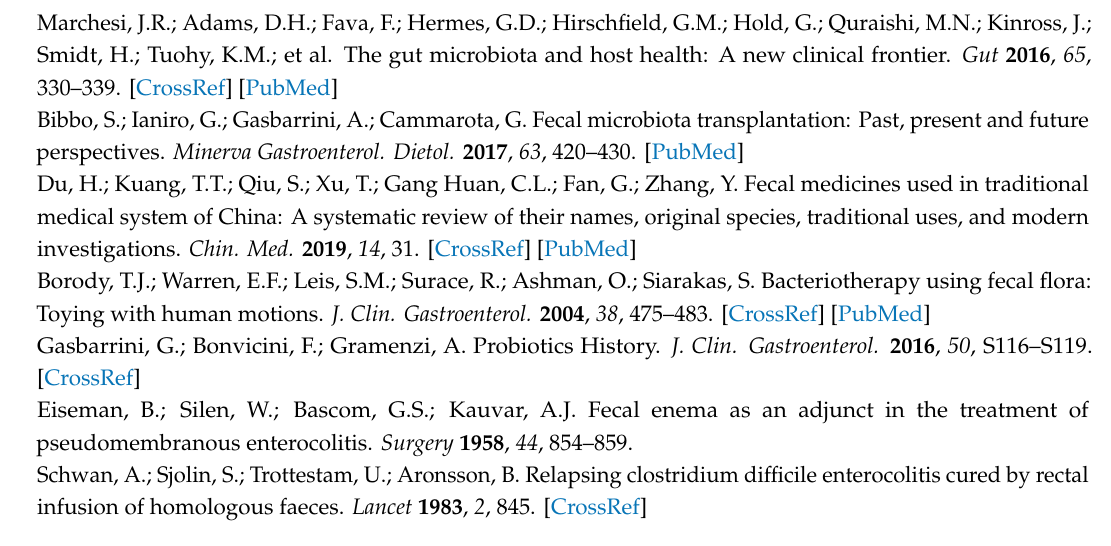
Figure S1: Optimal Stool Donor to Treat Specific